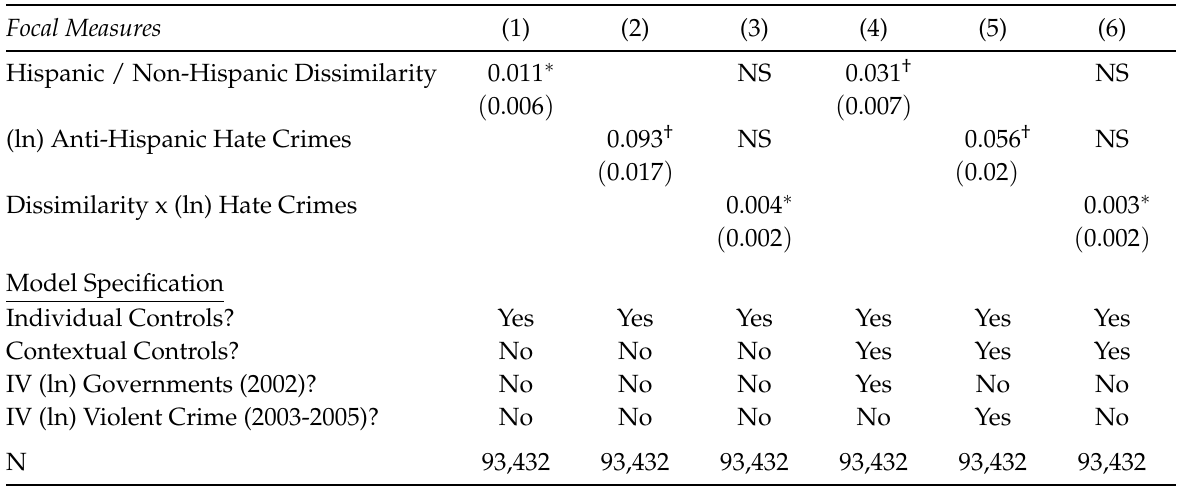
Table 2: Probit Estimates of Hispanic ’Other Race’ Identification: Instrumenting with Number of Governments and Violent Crimes, American Community Survey 2009 Focal